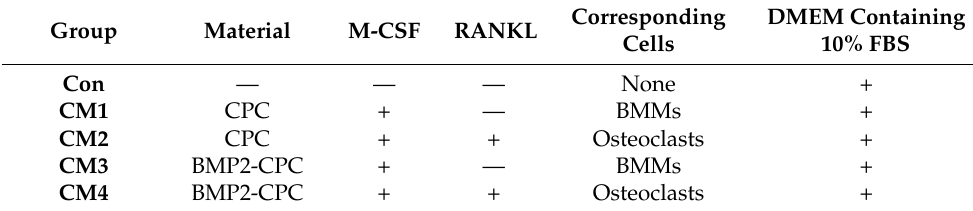
Table 5. The groups of